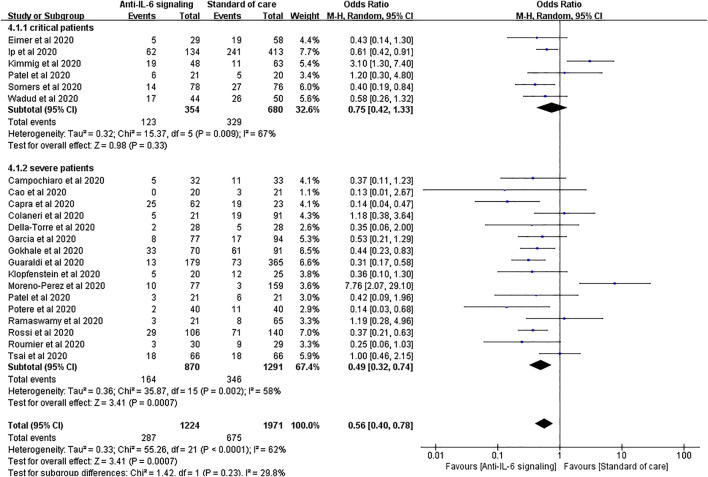
Subgroup analysis according to severity of patients with COVID-19 for pooled odds ratio of mortality. Subgroup analysis compared the risk of mortality in groups of severe or critical patients with COVID-19 separately. Six studies were included in the subgroup of critical patients, including 354 treated patients and 680 controls. There was no statistical difference in the risk of mortality between the two groups of critical patients (pooled OR = 0.75, 95% CI 0.42–1.33, p = 0.33). Sixteen studies were included in the subgroup of severe patients, including 870 treated patients and 1,291 controls. The mortality rate in the anti-IL-6 signaling treatment group was remarkably reduced (pooled OR = 0.49, 95% CI 0.32–0.74, p = 0.0007) compared to the SOC group in patients with severe disease.